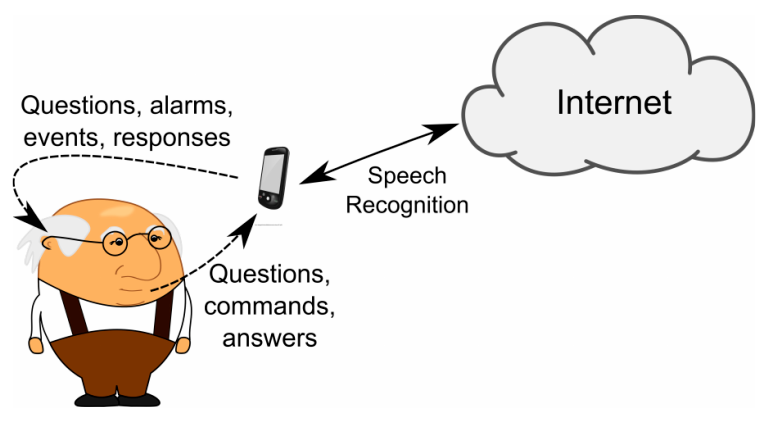
Figure 9. InHandheld Agent in the Android